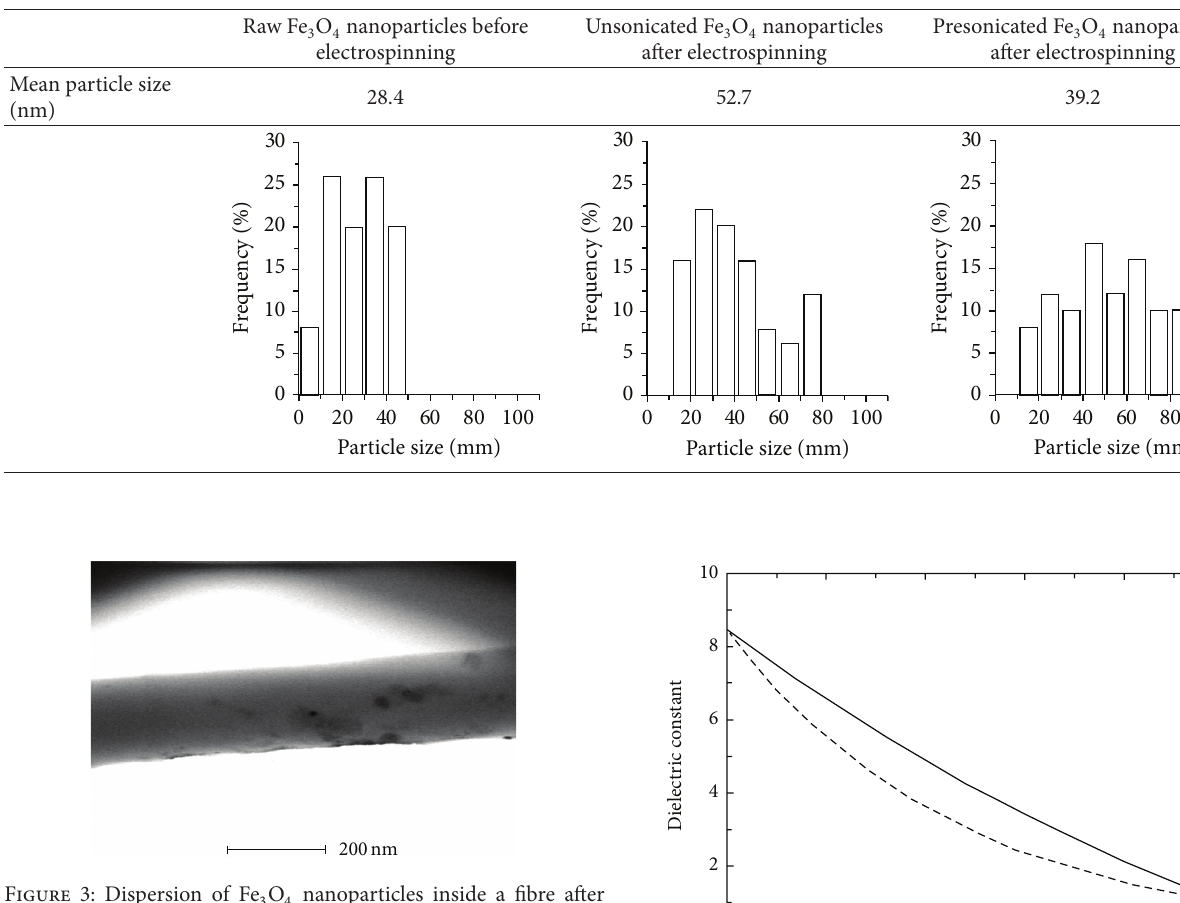
Table 1: Mean size of Fe